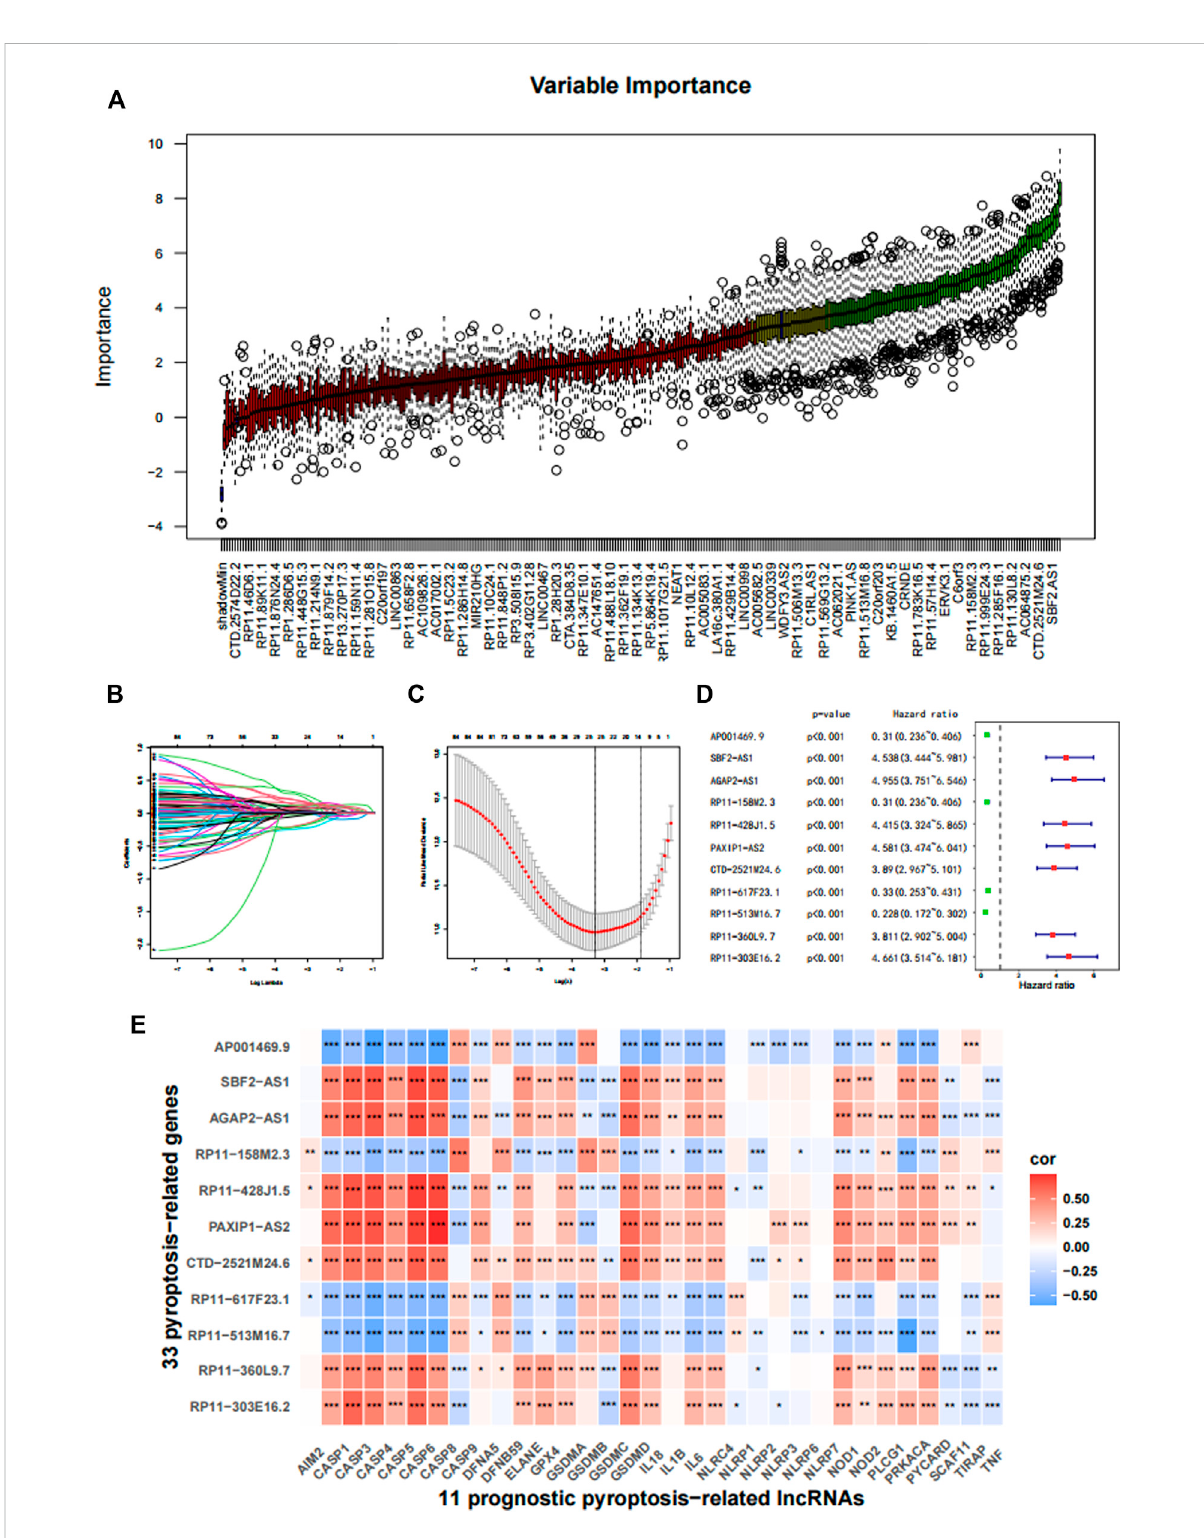
FIGURE 2 Constructionoftheprognostic pyroptosis-related lncRNA(PRL)classi fi er. (A) TheBorutaalgorithm wasused toselect importantfeatures. (B,C) TheLASSOcoxregressionwasconductedbasedontheminimumparameters. (D) The11PRLswereanalyzedusingunivariateCoxregression. (E) The association of the 33 pyroptosis-related genes with 11 PRLs in TCGA cohort. * p < 0.05, ** p < 0.01, and *** p <